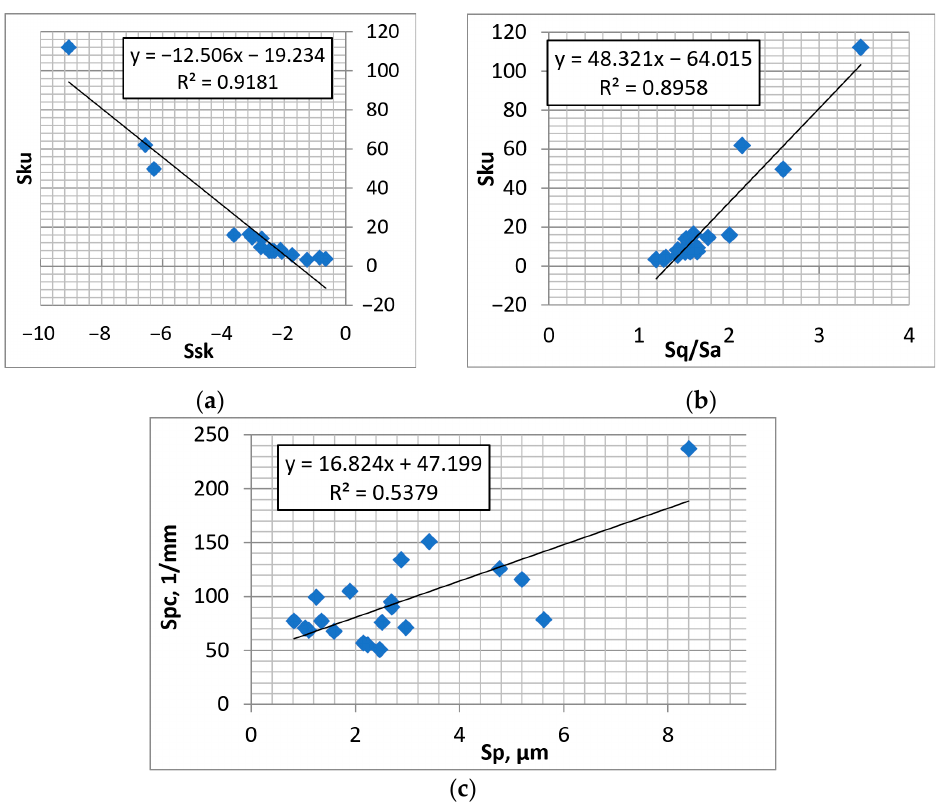
Figure 9. Dependencies between parameters: Ssk–Sku ( a ), Sq/Sa–Sku ( b ), and Sp–Spc ( c ) of textured surfaces containing isolated dimples.